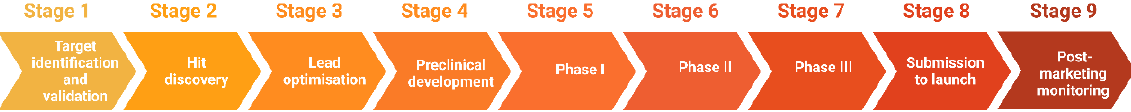
Figure 1. Stages of drug discovery and development.